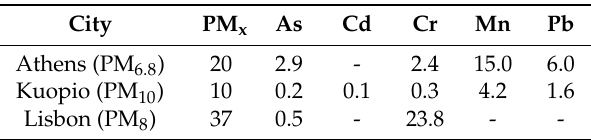
Table 3. Ambient PM x concentration ( µ g/m 3 ) and concentration of particle-bound metals (ng/m 3 ) measured in each city